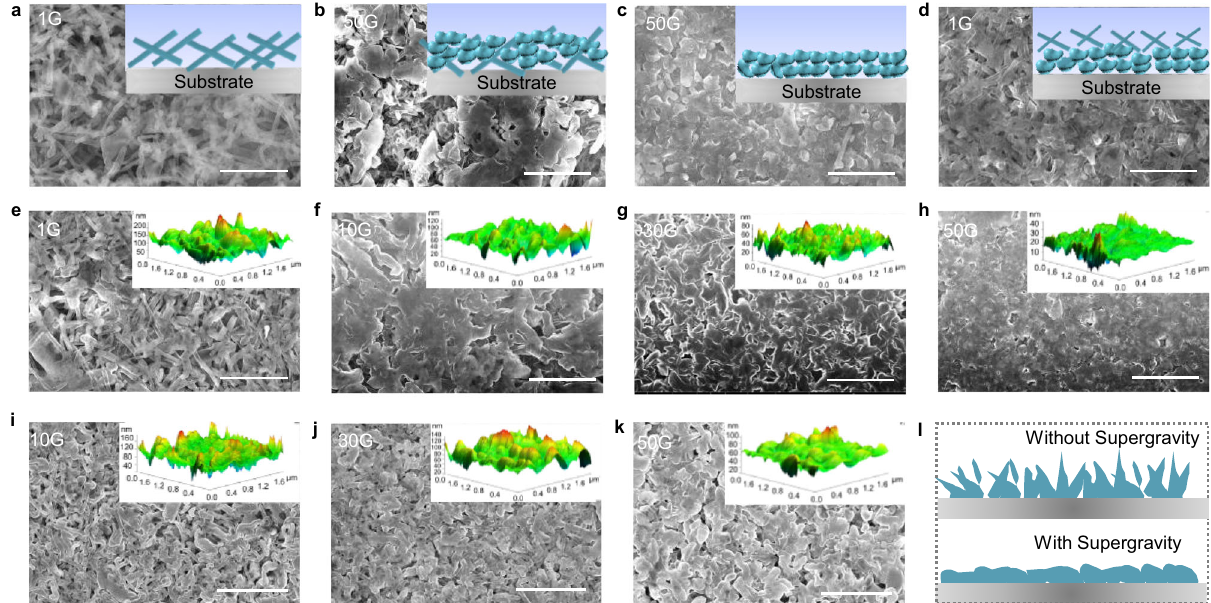
Fig. 2 Morphology characterization of Li metal under different gravity conditions. SEM images of deposited Li on Cu after plating 0.5 mA h cm − 2 at a 1G or c 50G, and then continues to plate 0.5 mA h cm − 2 at b 50G or d 1G. SEM images of deposited Li on Cu after plating 1 mA h cm − 2 under e − h parallel and i − k perpendicular supergravity directions. l Schematic illustration of electrodeposition morphology under different gravity conditions. Note that the images inserted in the upper right corner are used to illustrate the corresponding morphological evolution, including a − d sketches drawn and e − k 3D topography from AFM. Scale bars are 5 μ m in ( a − k